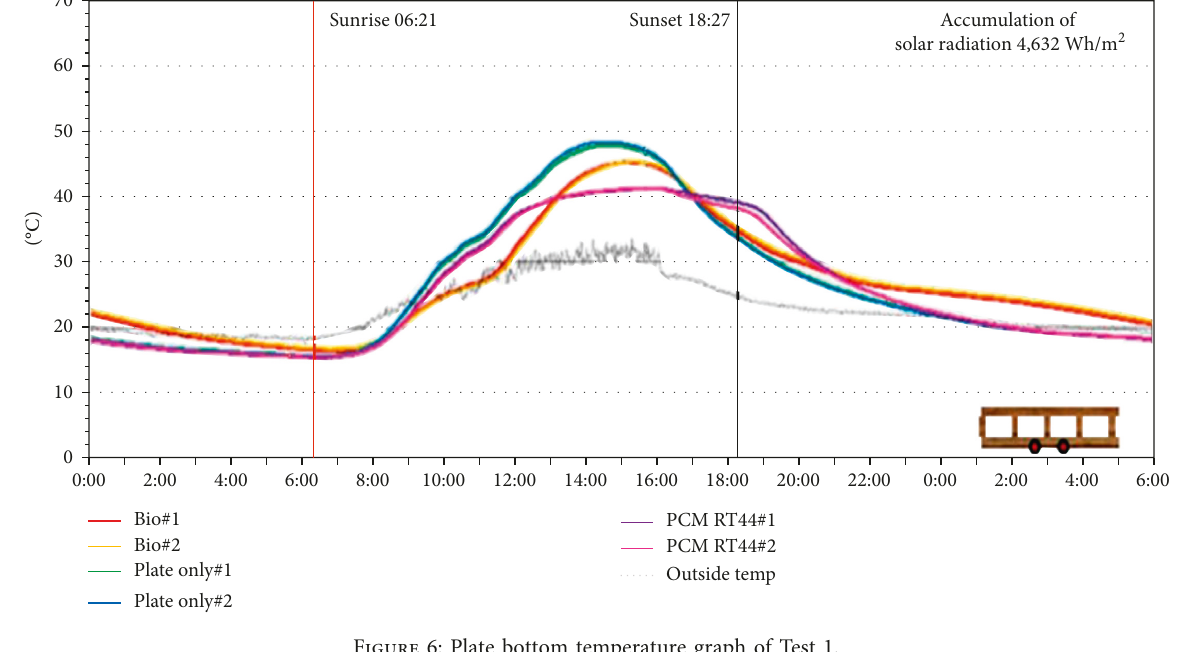
Figure 6: Plate bottom temperature graph of Test 1.